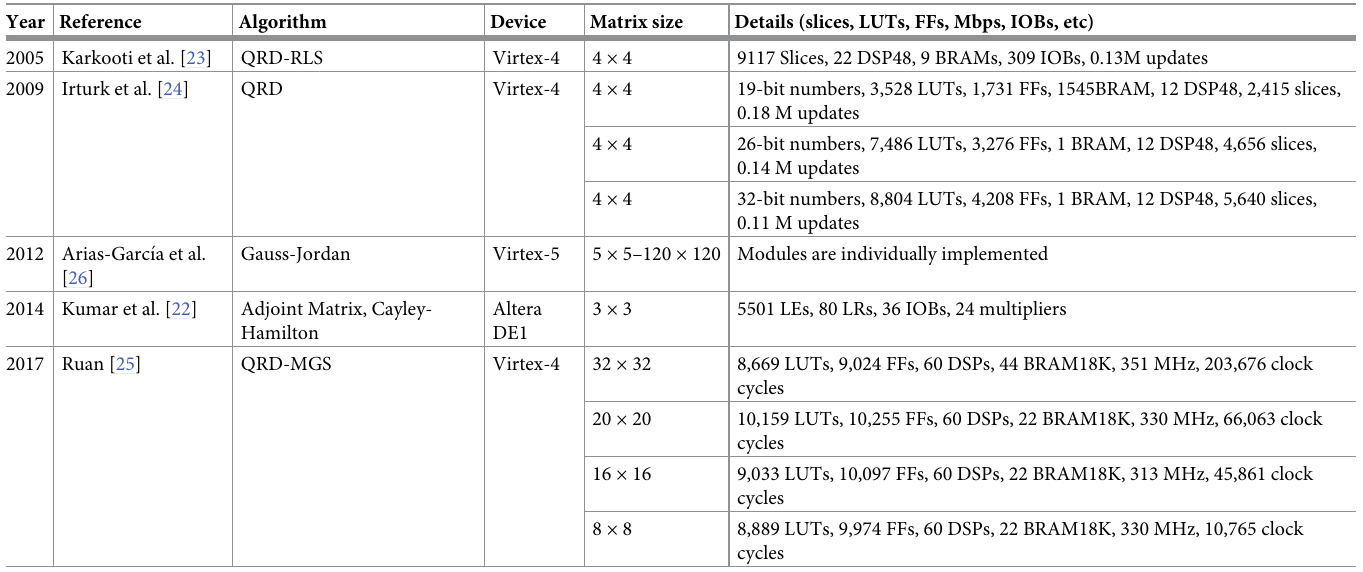
Table 10. Comparative table with respect to other FPGA implementations of matrix inversion